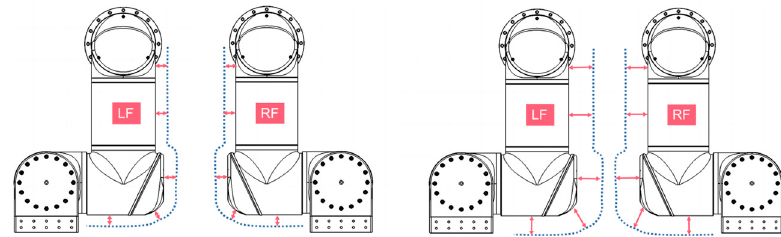
Figure 15. The detection distance increases with an increase in K.